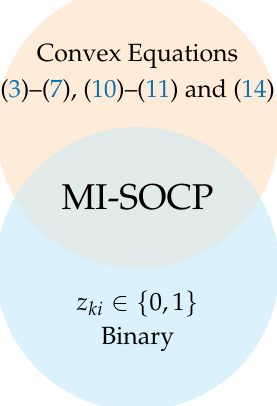
Figure 3. Equivalent MI-SOCP model for the problem of the optimal location and sizing of capacitor banks in distribution